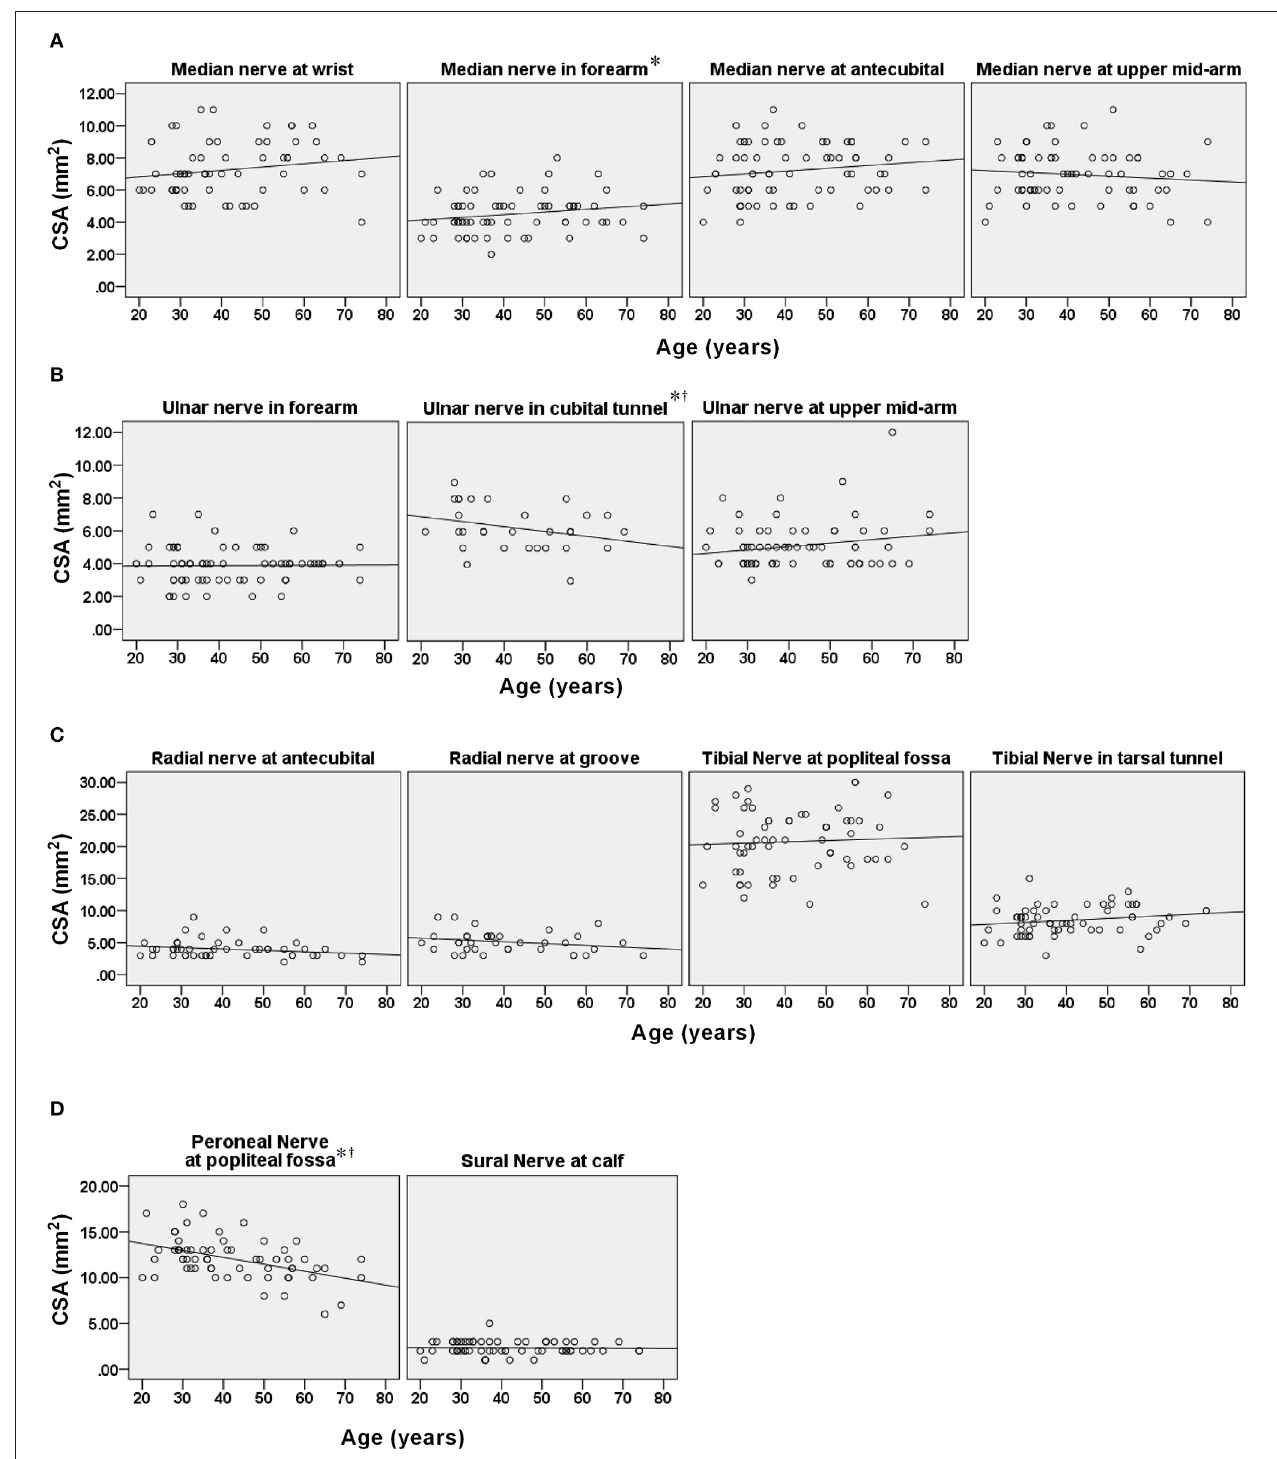
FIGURE 4 | Scatter plot showing correlation of age with cross-sectional area (CSA) at different sites of nerve. (A) Median nerves. (B) Ulnar nerves. (C) Radial nerves and (D) Peroneal and sural nerves. *Statistically significant correlation in: median nerve in the forearm, ulnar nerve in cubital tunnel, and peroneal nerve in the popliteal fossa. † Statistically significant correlation under false discovery rate multiple testing